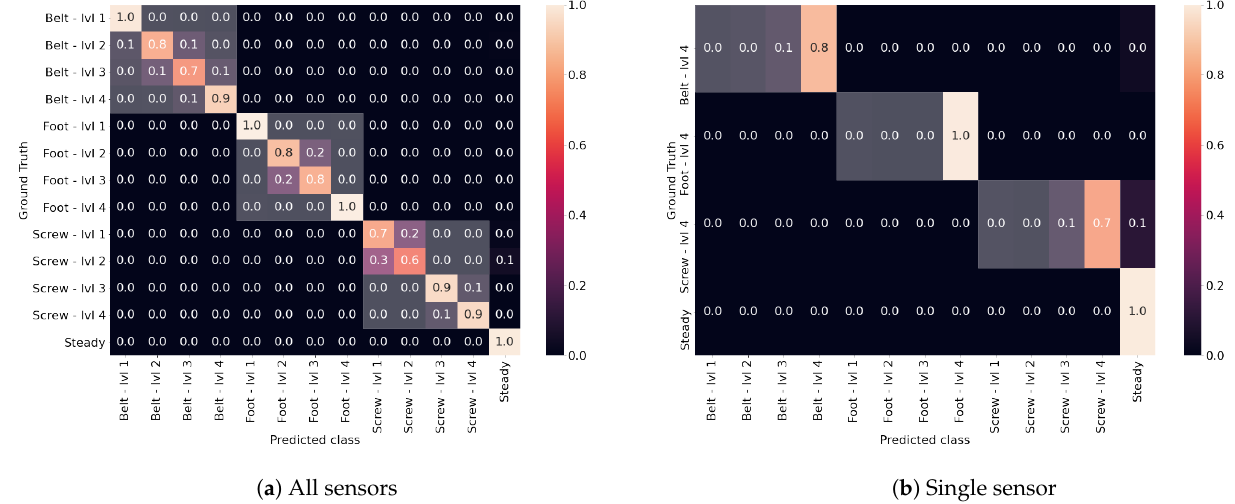
Figure 9. Confusion matrix of the classifier among different issues and different issue